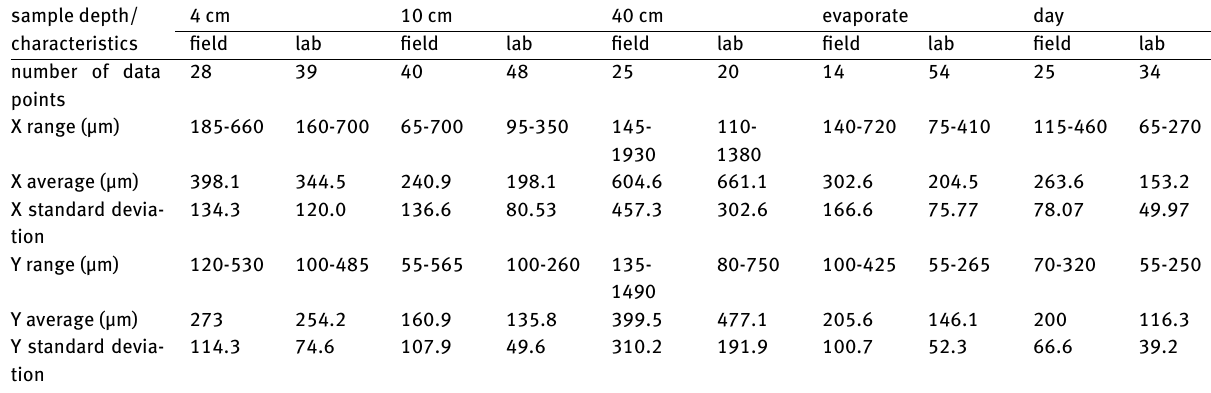
Table 4. Summary of numerical differences between the field and laboratory data based images using the same camera, analysing the layers of the 0601 sampling site. (X value: the longest diameter of the grains, Y value: the shortest diameter of the grains, which are perpendicular to each